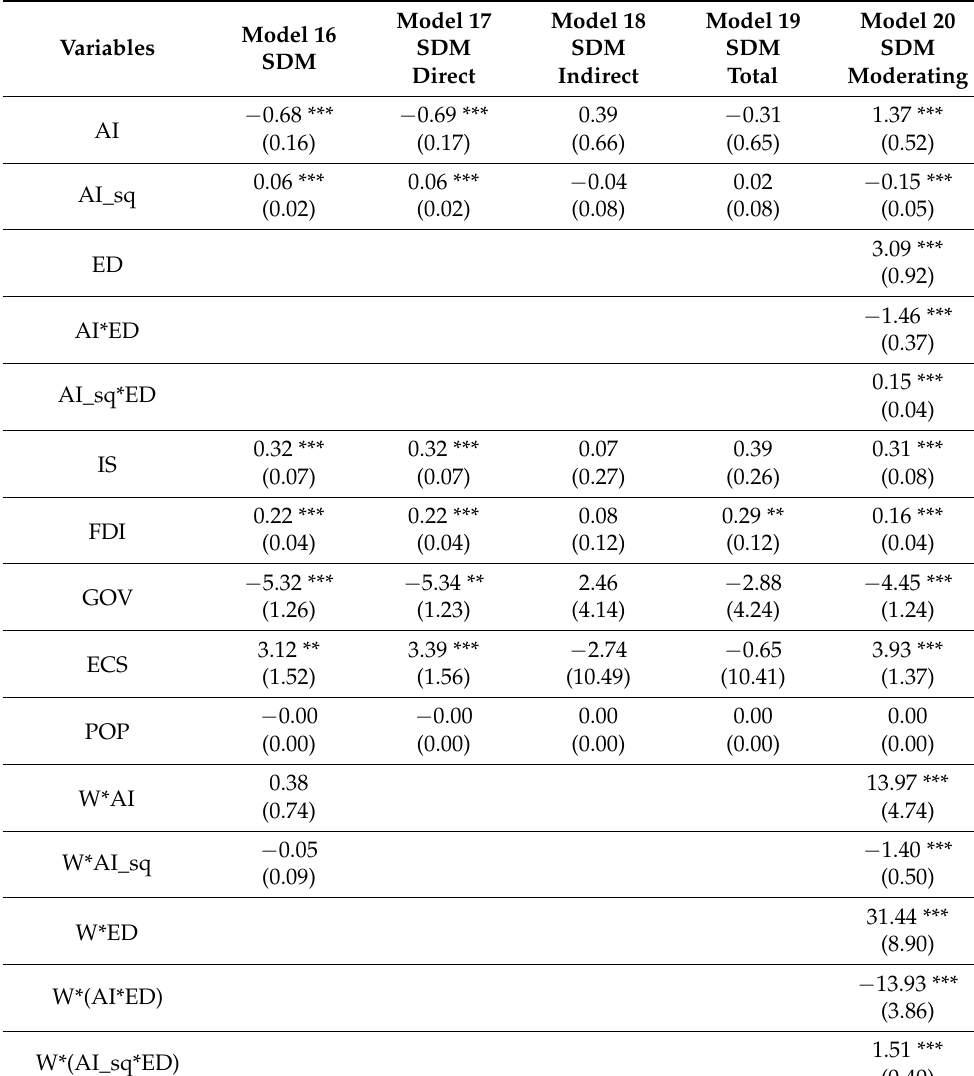
Table 8. Spatial basis regression results—based on MAUP.